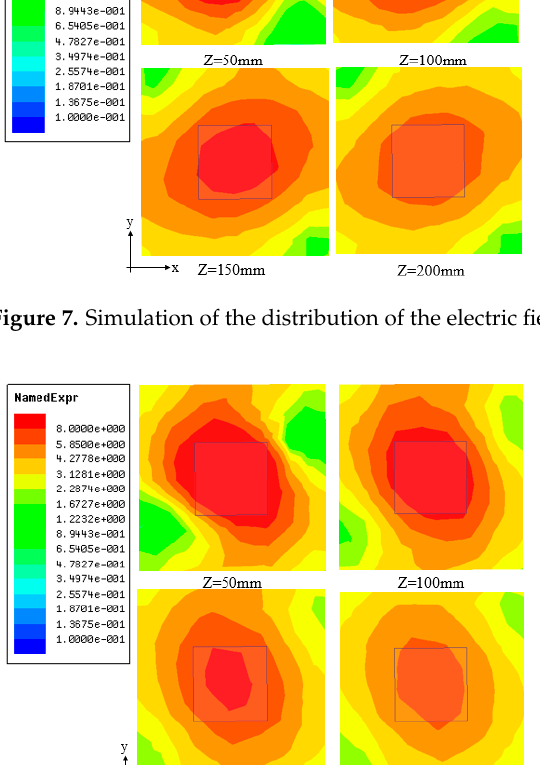
Figure 7. Simulation of the distribution of the electric field component Ex at different heights.